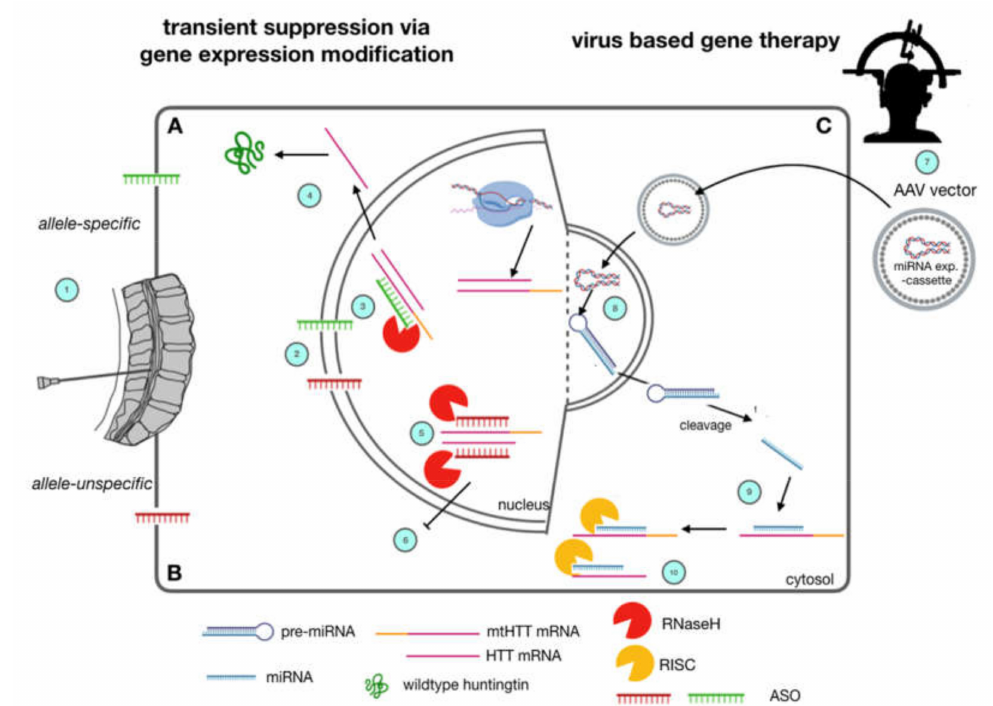
Figure 1. Huntingtin-lowering strategies currently under clinical investigation in Huntington’s Disease. Allele-specific ( A ) and allele-unspecific ( B ) Antisense Oligonucleotide (ASO) strategies as well as virally mediated strategies ( C ) are currently being evaluated in clinical trials. ASOs (A, B) are applied via lumbar puncture (1). They are supposed to reach the cerebral cortex and deeper brain regions via di ff usion along the neuraxis through cerebrospinal fluid CSF turnover. They enter brain cells and nuclei due to their lipophilic backbone modification (2). By Watson-Crick base pairing, they bind to both mutant htt and wild type htt (5, allele-unspecific) or mutant htt (3, allele-specific). This leads to nuclear RNaseH mediated degradation of pre-mRNA and mRNA and a subsequent lowering in htt protein levels of wt and mt htt (6) or mt htt, only (4). Gene-Therapeutic strategies (C) rely on a single stereotactic injection into the striatum (7) of adeno-associated viruses carrying a mi-RNA expression cassette, which is able to enter neuronal nuclei, and express a miRNA construct (8). After cleavage, this construct suppresses expression of mutant htt by RNA interference (9) and subsequent degradation by the cytosolic RISC complex